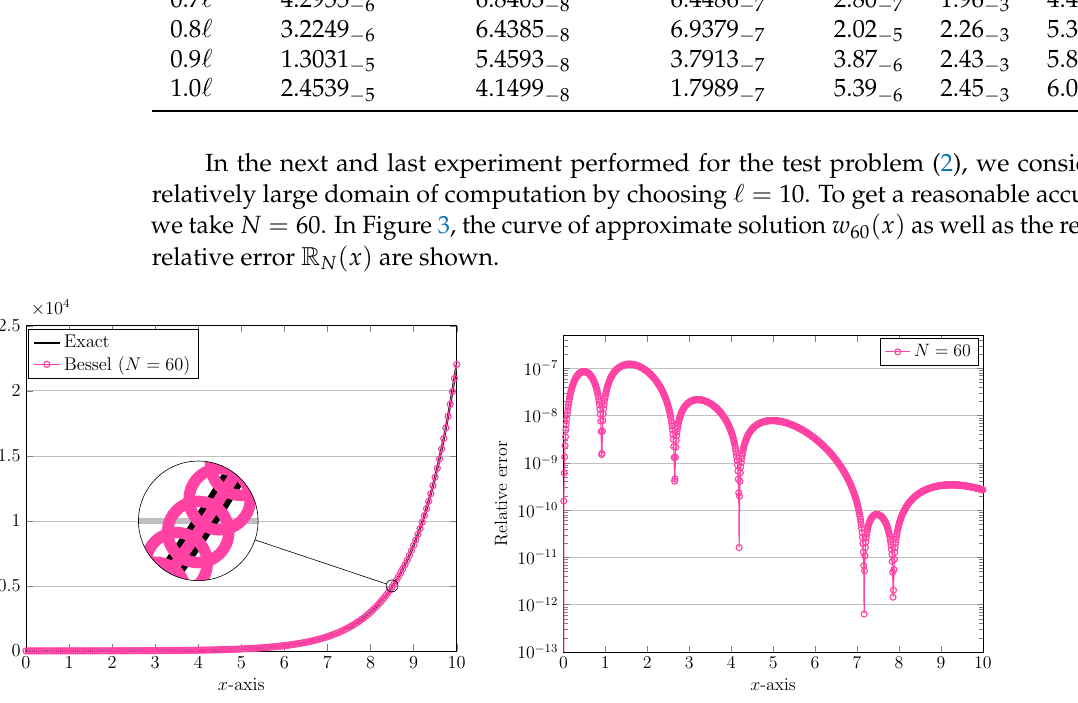
Figure 3. Graphs of the exact and computed solutions using N = 60 ( left ) and the resulting absolute error ( right ) for (cid:96) = 10 in Example